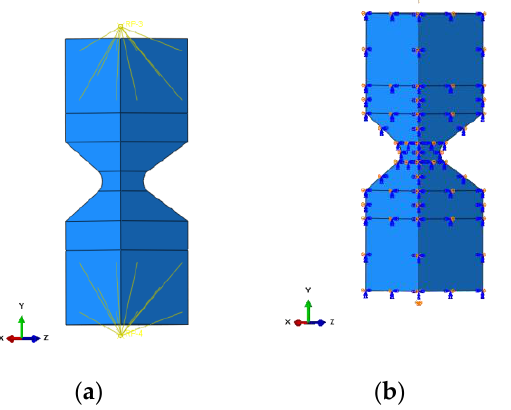
Figure 2. Representation of boundary conditions applied to the specimen, ( a ) coupling connection, ( b ) symmetry boundary conditions.